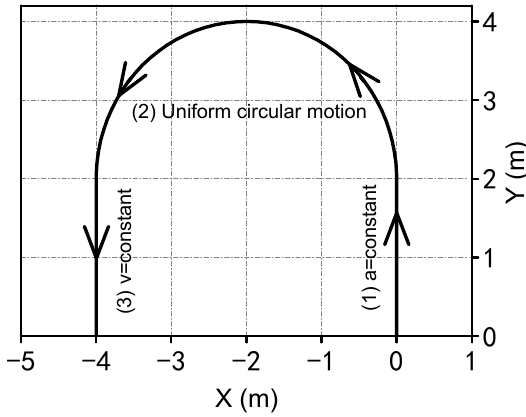
Figure 7. Plane view of the towing trajectory.